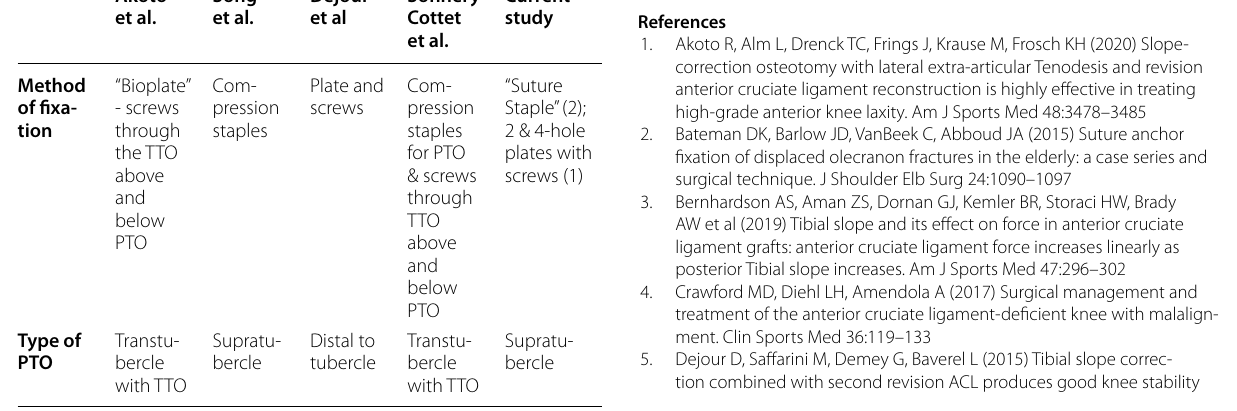
TTO Tibial Tubercle Osteotomy, PTO Proximal Tibial Osteotomy